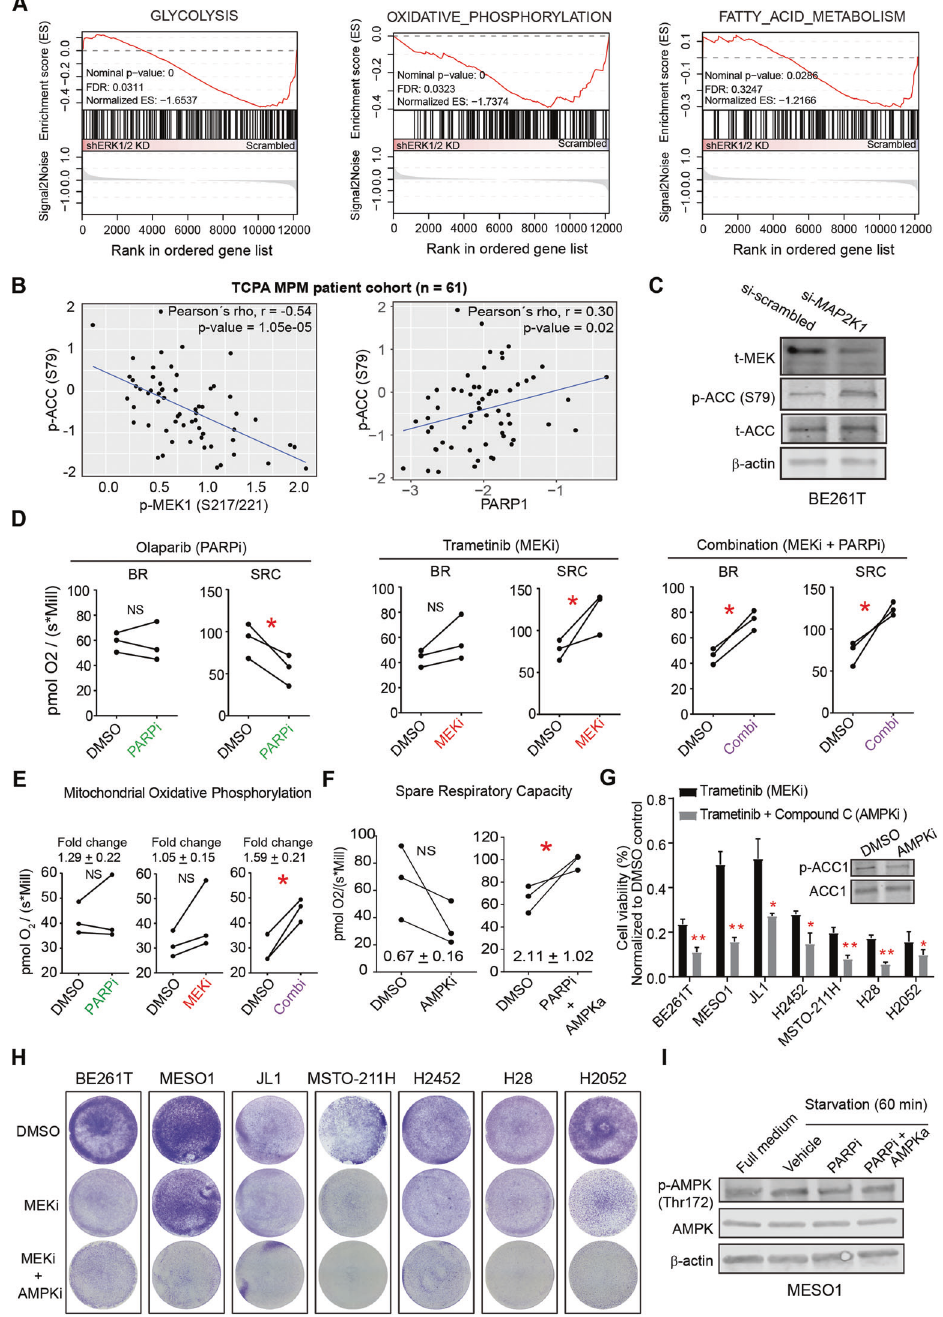
Fig. 5 PARP-AMPK-regulated SRC protects MEKi-induced metabolic stress. A Gene set enrichment analysis (GSEA) showed that downregulation of ERK1/2 signi fi cantly decreased transcriptional signatures of glycolysis, oxidative phosphorylation, and fatty acid metabolism. The GEO dataset GSE21750 was used for GSEA. B p-ACC (Ser79) protein level negatively correlates with p-MEK1 but positively with PARP1 in MPM patients. The protein expression data [reverse-phase protein array (RPPA)] were downloaded from The Cancer Proteome Atlas (TCPA) portal (https://tcpaportal.org/). C Immunoblots of BE261T cells transfected (72 h) with si- MAP2K1 or scrambled siRNAs. D Respirometric measure ( n = 3) of basal respiration (BR) and spare respiration capacity (SRC) in MESO1 cells treated with MEKi (0.5 μ M trametinib) and PARPi (5 μ M olaparib) for 72 h. * p < 0.05 by paired t -test. E Quanti fi cation of mitochondrial oxidative phosphorylation (OXPHOS) in MESO-1 cells treated with DMSO, PARPi, MEKi, and the combination. * p < 0.05 by paired t -test ( n = 3). F Quanti fi cation of spare respiratory capacity (SRC) in MESO-1 cells treated with DMSO, AMPK inhibitor (AMPKi), and the combination of PARPi and AMPK activator (AMPKa). * p < 0.05 by paired t -test ( n = 3). G , H Viability (72 h; G) and clonogenic (1 week; H) assay of MPM cells treated with MEKi (0.5 μ M), in the presence or absence of compound C (5 μ M). Shown in the insert ( G ) are immunoblots of BE261T cells treated with DMSO or compound C for 12 h. * p < 0.05, ** p < 0.01, by Welch ’ s t -test. I Immunoblots of MESO1 cells starved (60 min) and co-treated (60 min) with compound C (AMPKi; 5 µM), AICAR (AMPKa; 1 mM), and olaparib (PARPi; 5 µM). Quanti fi cation of phospho-proteins was normalized to its total protein and the β -actin.